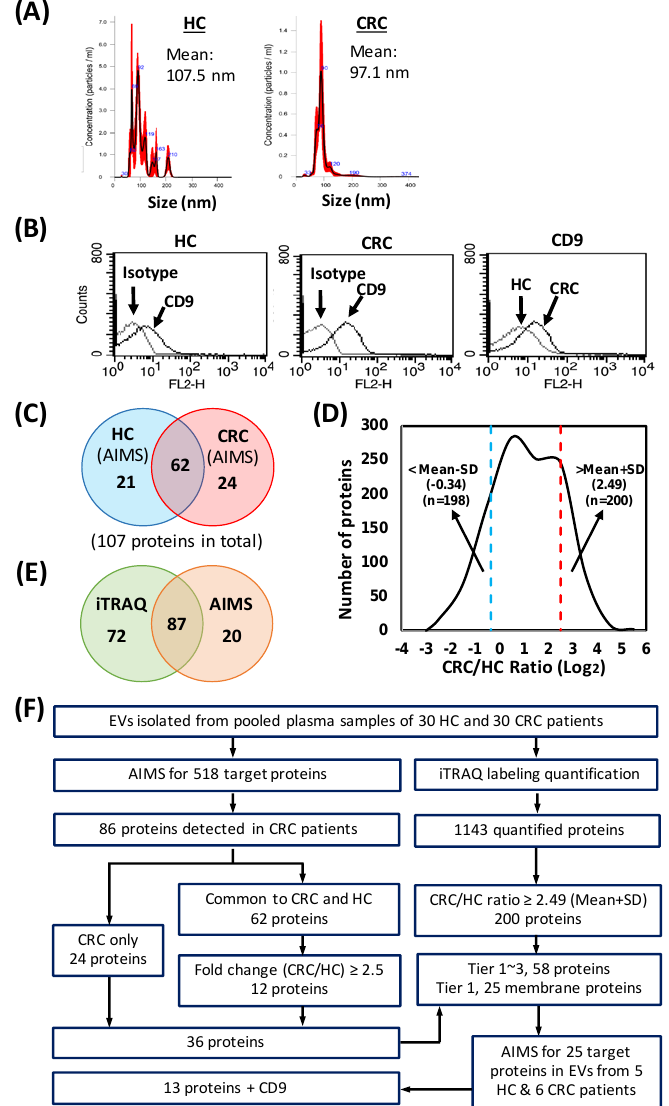
Figure 4. AIMS- and iTRAQ-based proteomic analysis of EVs prepared from plasma samples pooled respectively from HCs and CRC cases (n = 30/group). ( A , B ) Nanoparticle tracking analysis ( A ) and FACS analysis ( B ) of EVs isolated from pooled HC and CRC cases. Mouse IgG1K was used as an isotype control in FACS analysis. ( C ) Venn diagram showing proteins detected by AIMS in EVs isolated from pooled HC and CRC cases. ( D ) Log2 ratio distribution of the 1143 plasma EV proteins differentially expressed between CRC and HC groups, quantified by iTRAQ-based proteomic analysis. Dashed lines indicate boundaries at means ± SD. ( E ) Venn diagram showing the number of iTRAQ-identified proteins and the number of proteins common to AIMS and iTRAQ identification from the list of target proteins selected for AIMS. ( F ) Flow chart of the selection and categorization of prioritized candidates for further verification by targeted MS.